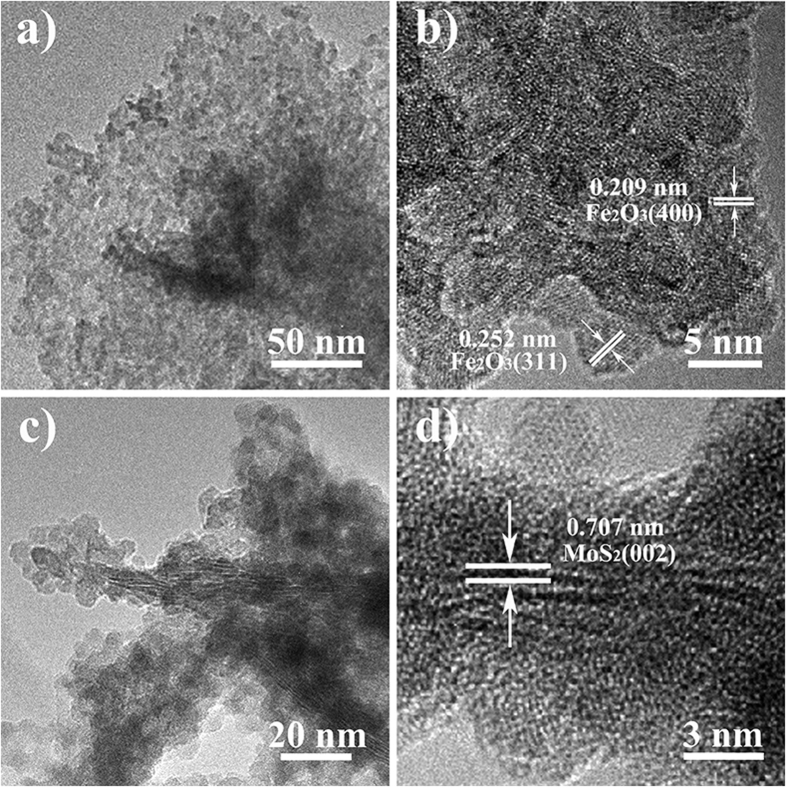
TEM image of Fe2O3/MoS2 composite.(a,b) TEM and HRTEM images taken from basal plane, and (c,d) cross-section TEM and HRTEM image of basal plane.